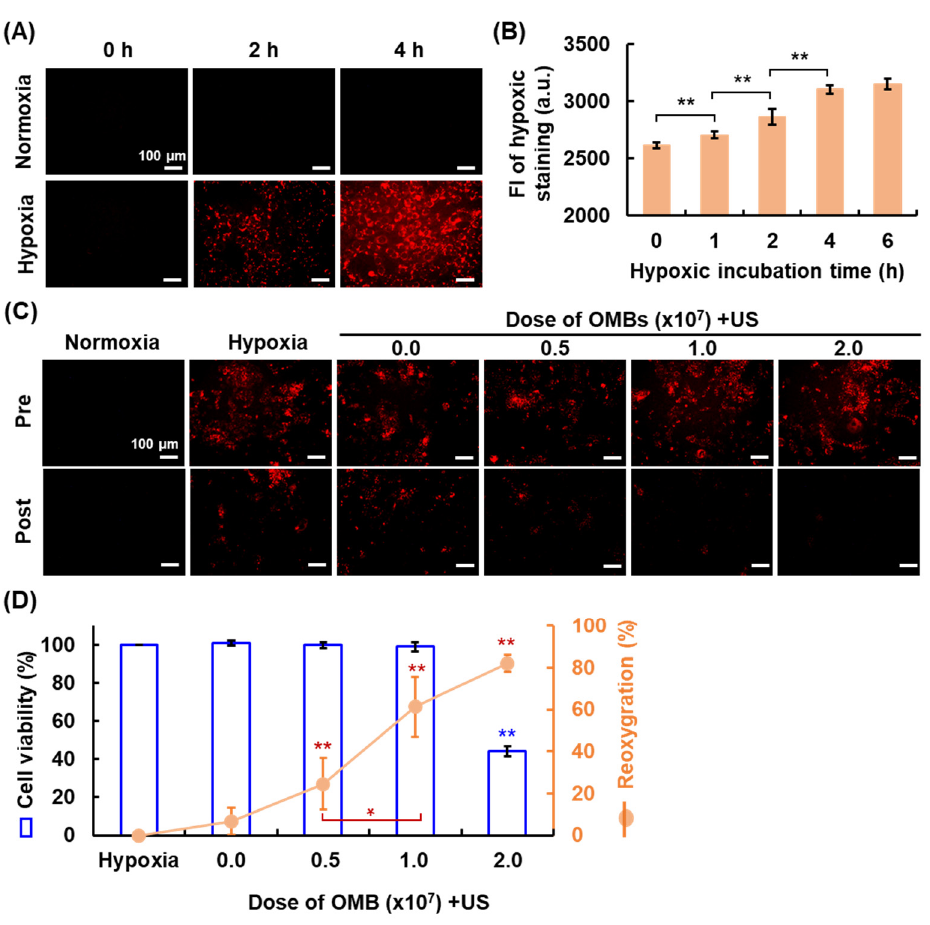
Figure 6. The hypoxic tumor cell model and reoxygenation. ( A ) Fluorescent images reveal HDR cells stained red by Image-iT TM Red hypoxia reagent. ( B ) The corresponding quantification data for FI on cell imaging (** p < 0.01). The optimal dose of OMB for cell reoxygenation after OMB treatment was determined by ( C ) the fluorescent cell imaging and ( D ) the correlation between cell viability and the percentage of reoxygenation (* p < 0.05, ** p < 0.01).